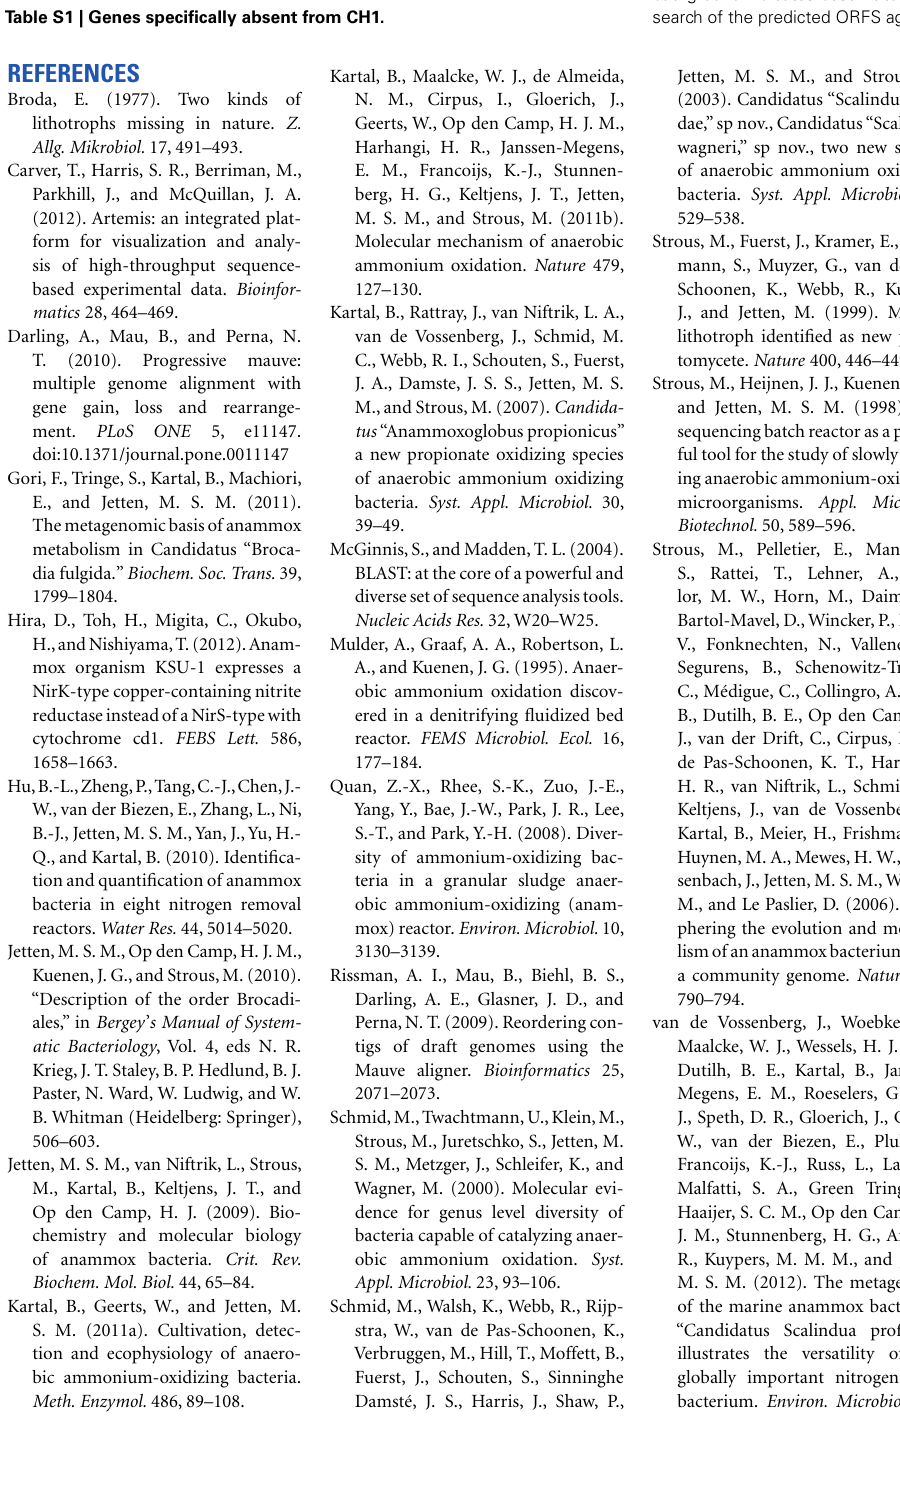
Table S2 | Kust genes without unique reads. Yellow background indicates genes of which the up and downstream sequence is continuous in the CH1 assembly. Table S3 | Predicted ORFs not aligning to the Kust genome. Yellow background indicates best hit to the Kust genome. Data results from a BLASTp search of the predicted ORFS against the NCBI nr